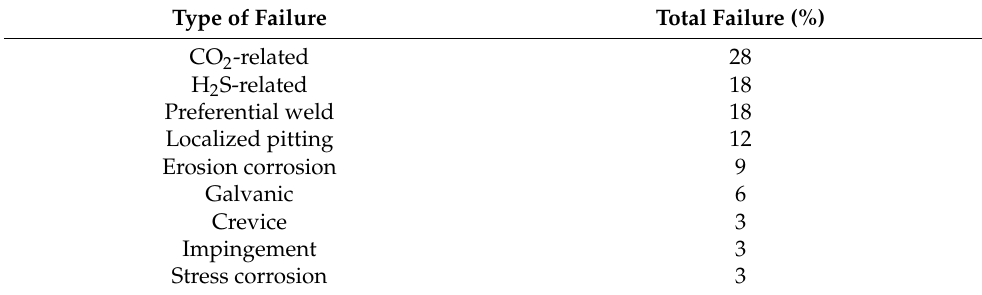
Table 1. Cause of corrosion-related failure in petroleum-related industries [1].